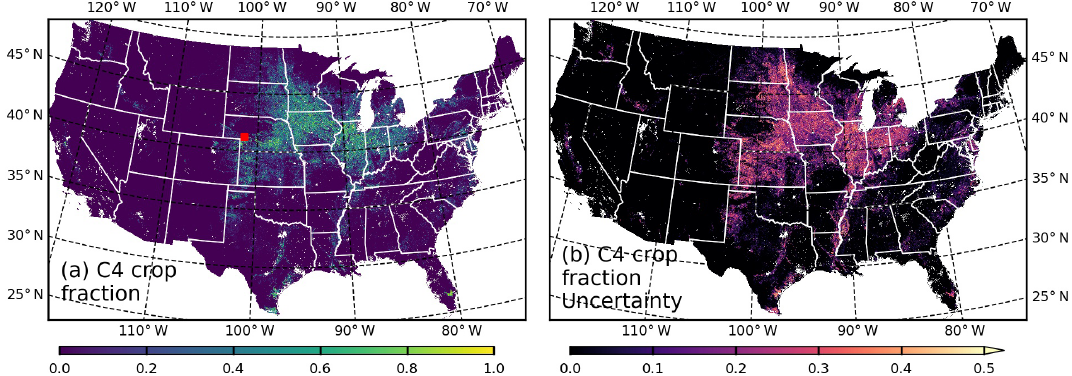
Figure 7. Spatial distribution of 250m resolution (a) predicted fraction of C4 crop in vegetation in 2000 and (b) C4 crop fraction uncertainty across the